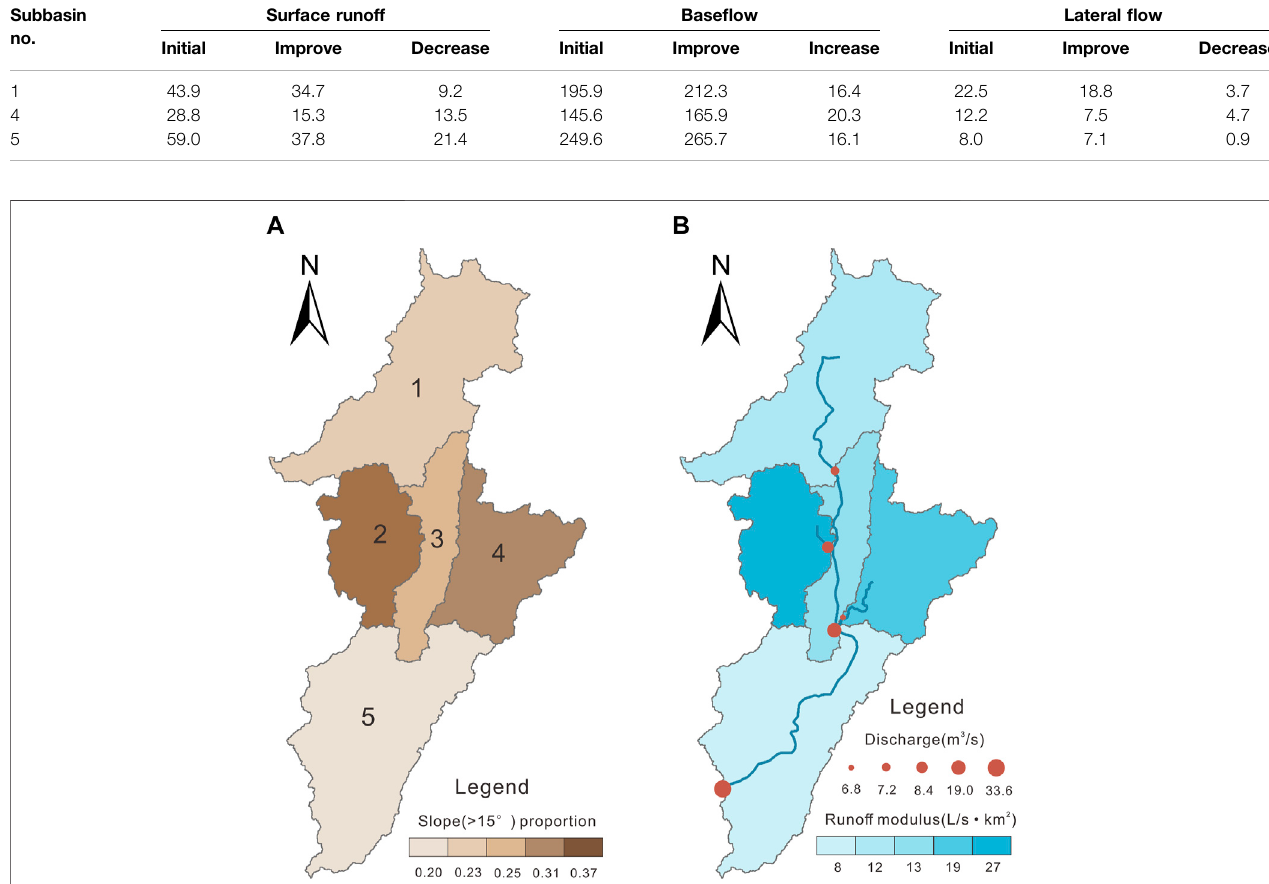
Frontiers in Environmental Science |